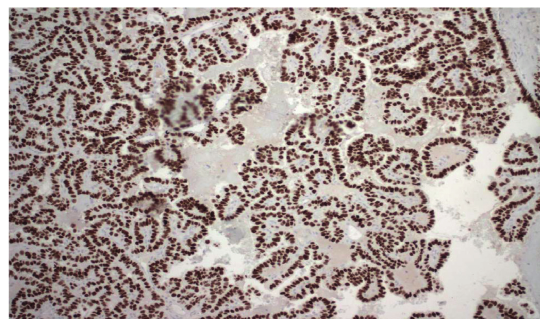
Figure 7: Immunohistochemistry for thyroid transcription factor- 1 (TTF-1) was diffusely positive in tumor cells. This supports the tumor’s thyroid